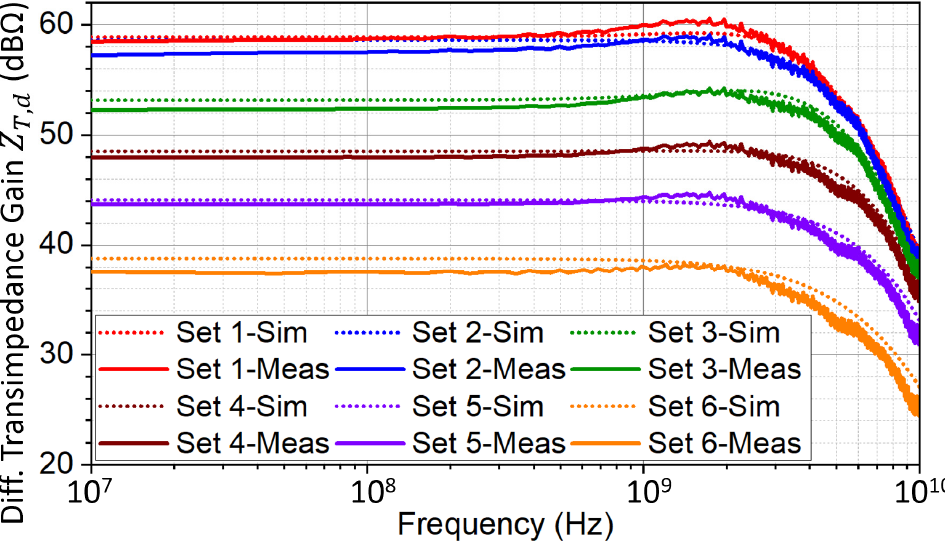
Figure 7. Simulated and measured differential transimpedance gain of the TIA at different gain settings.